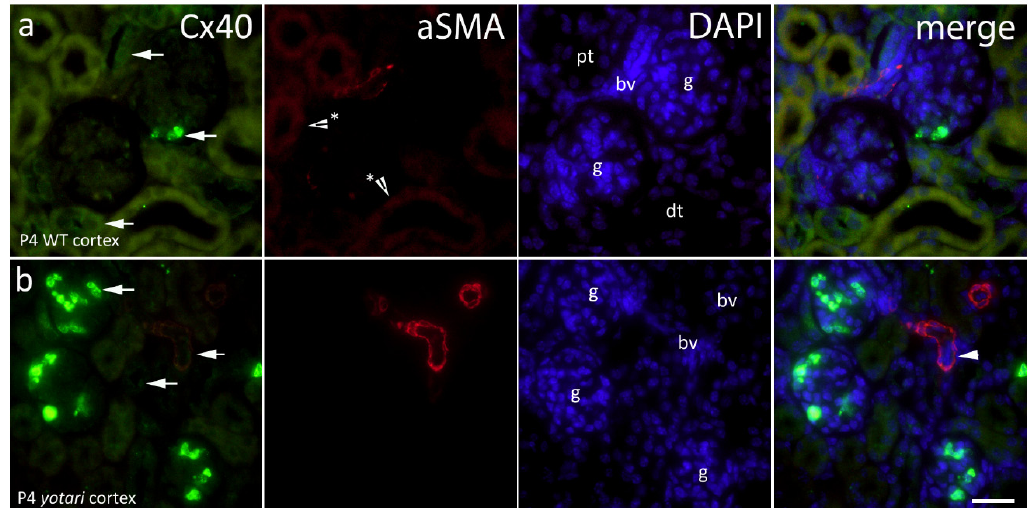
Figure 3. Immunofluorescence staining of postnatal yotari ( b ) and wild type ( a ) mouse kidneys with the Cx40 marker and co-expression of Cx40 and aSMA with DAPI nuclear staining. Expression of Cx40 (arrows), collecting tubules (ct), blood vessels (bv), glomeruli (g), proximal convoluted (pt), and distal convoluted tubules (dt). Co-expression of Cx40 and aSMA (arrowheads) can be seen on merged photographs. Autofluorescence of nephron tubules and erythrocytes (*), not to be mistaken with positive immunofluorescence staining. Scale bar is 20 μ m, refers to all images.